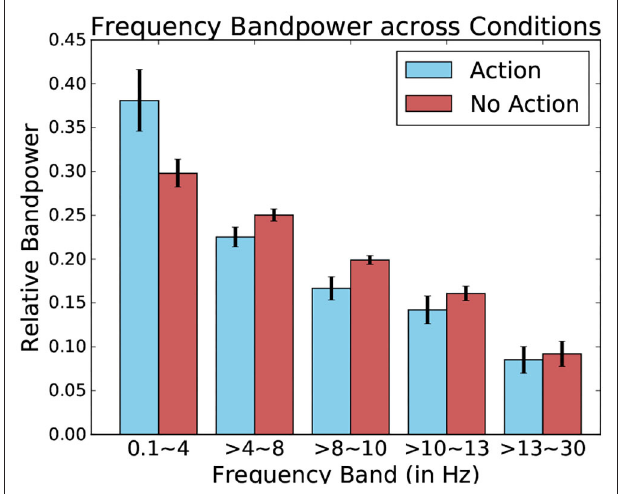
FIGURE 14 | Average potentials occurring at the onset of a key press performed to validate shape selection. Data from one participant was used for this